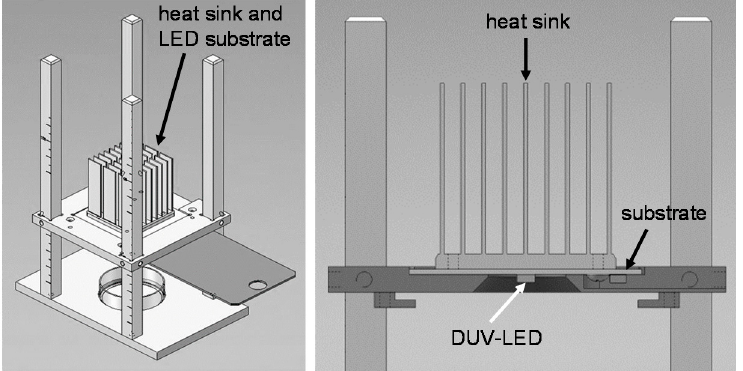
Figure 2. The apparatus for DUV-LED irradiation. The size of the DUV-LEDs was 3.5 mm × 3.5 mm. The size of the substrate of the LEDs was 35 mm × 35 mm × 5 mm. The length of the fins of the heat sink was 32 mm.